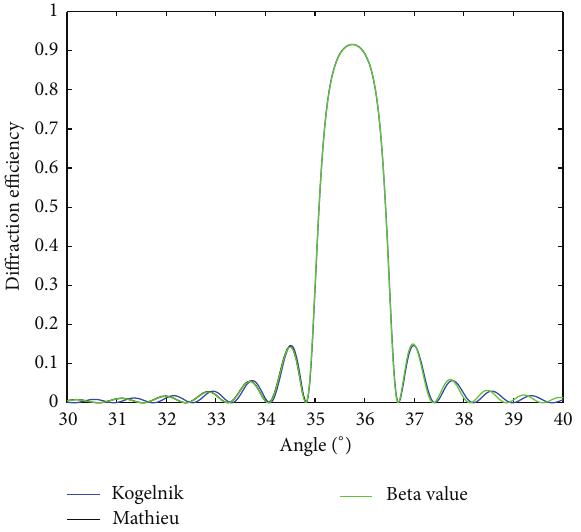
= 1.4 , and refractive II